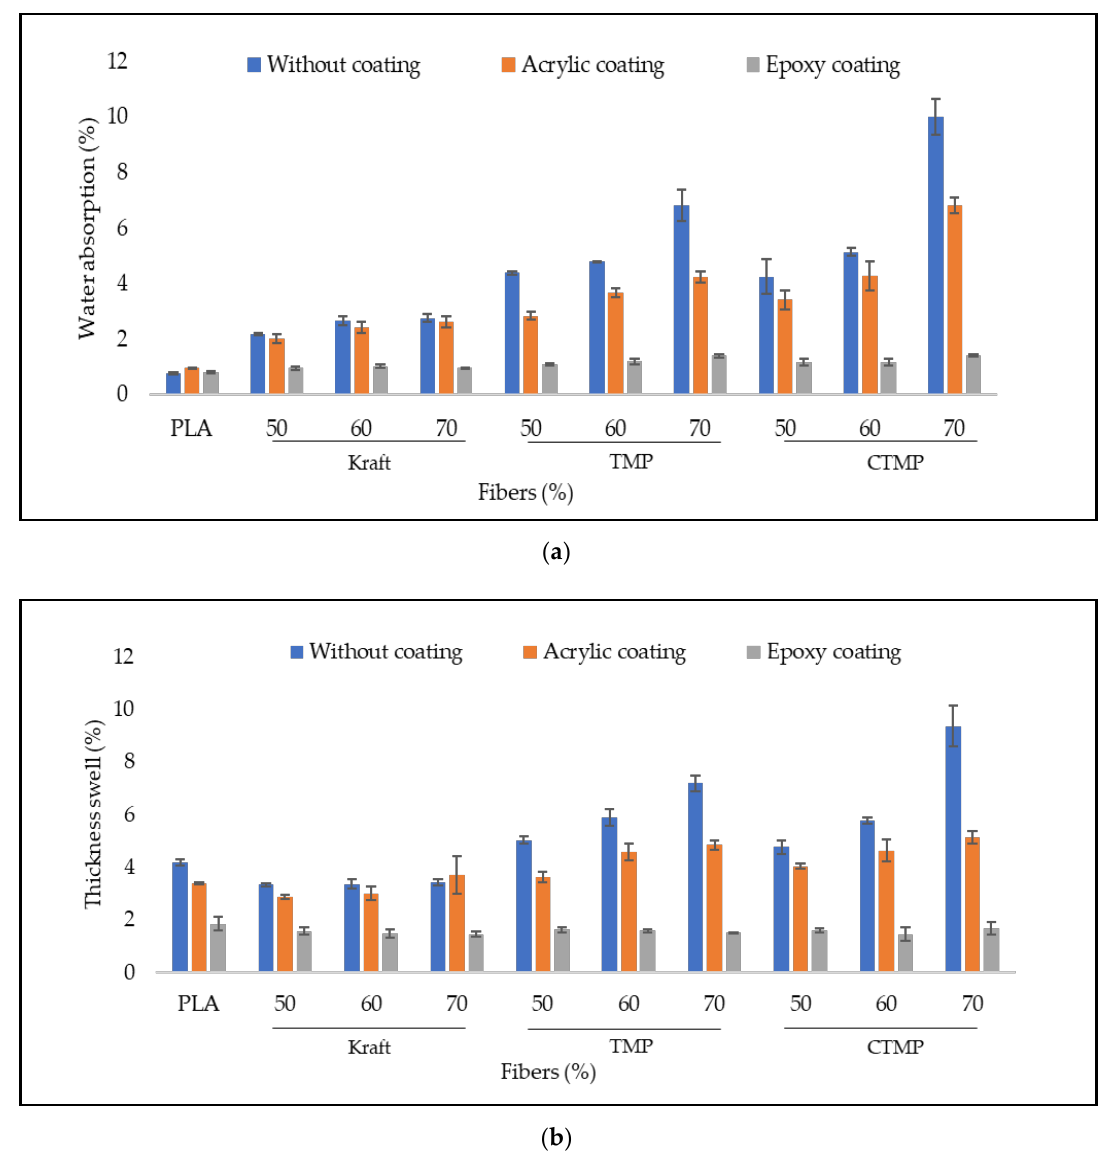
Figure 3. Comparison of the effect of the two types of coatings on water absorption of polylactic-acid-based composites: ( a ) Water absorption evolution and ( b ) thickness swell evolution.